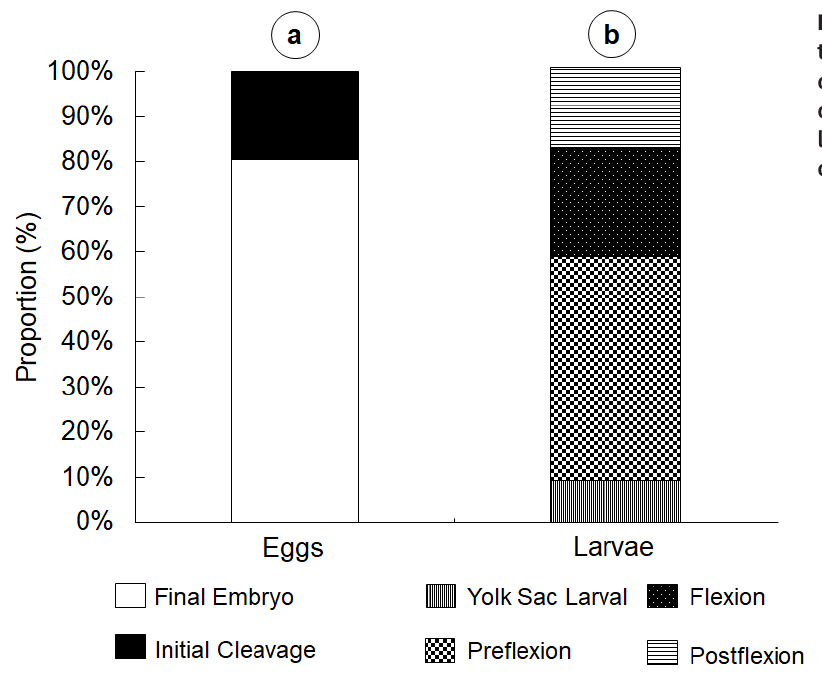
Figure 5. Variation of the capture proportion of development stages of a) fish eggs and b) larvae in Lake Juá, state of Pará,